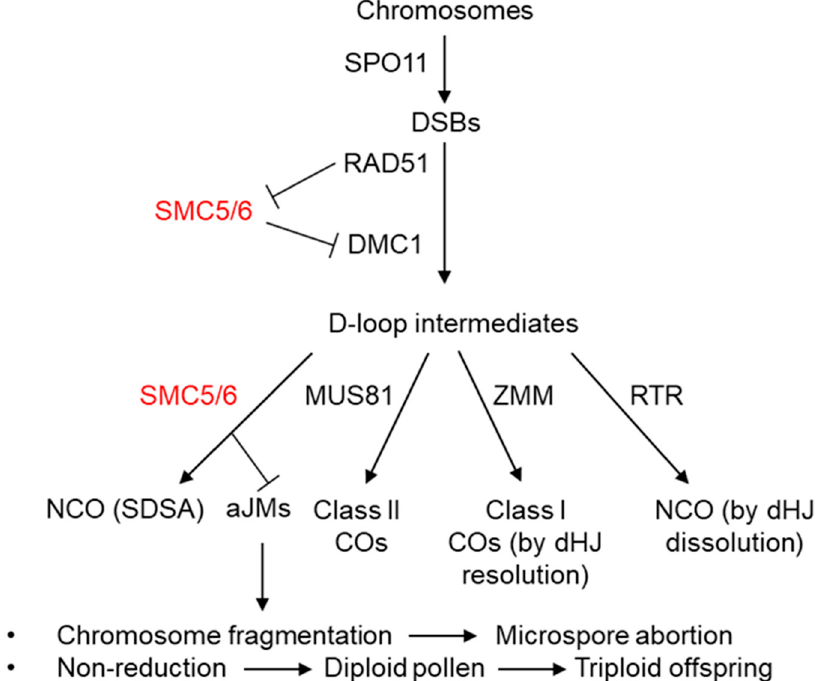
Figure 1. Simplified model of the functions of SMC5/6 complex during male meiosis in Arabidopsis. The meiotic double-strand breaks (DSBs) are initiated by SPO11. Recombinases RAD51 and DMC1, are required to repair the breaks by homology search and strand invasion, respectively. RAD51 supports the action of DMC1 by attenuating the SMC5/6 complex during this step [37]. The invasion of the homologous duplex DNA gives rise to a D-loop intermediate, which can be repaired by (i) non-crossovers (NCOs) via double Holliday junction (dHJ) dissolution by the RTR complex; (ii) by the ZMM pathway, forming Class I crossovers (COs) via dHJ resolution; (iii) by the MUS81-dependent pathway, forming Class II Cos; or (iv) by synthesis-dependent strand annealing (SDSA), generating NCOs. SMC5/6 is required to prevent the accumulation of aberrant and unresolved intermediates that arise outside the ZMM pathway [35]. The absence of SMC5/6 complex functions leads to the accumulation of abnormal joint molecules (aJMs), which are either repaired by MUS81, promoting Class II COs [36], or result in different abnormal phenotypes: either chromosome fragmentation and microspore abortion or lack of chromosome segregation, which results in the formation of diploid gametes and, finally, triploid offspring [37].